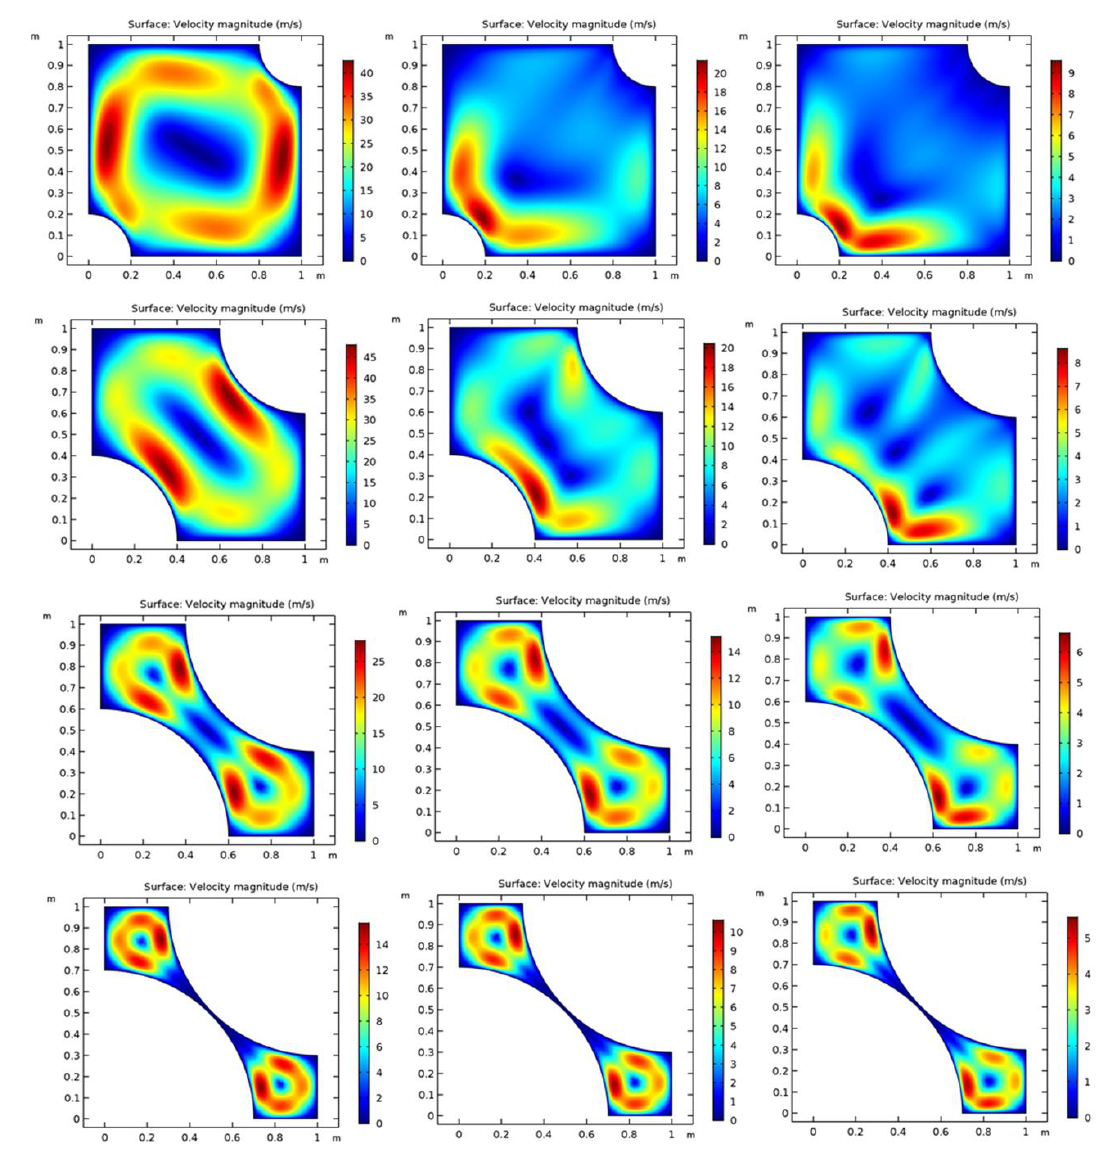
Figure 10. E ff ect of Hartmann number and round corner radius on the surface velocity magnitude distribution.